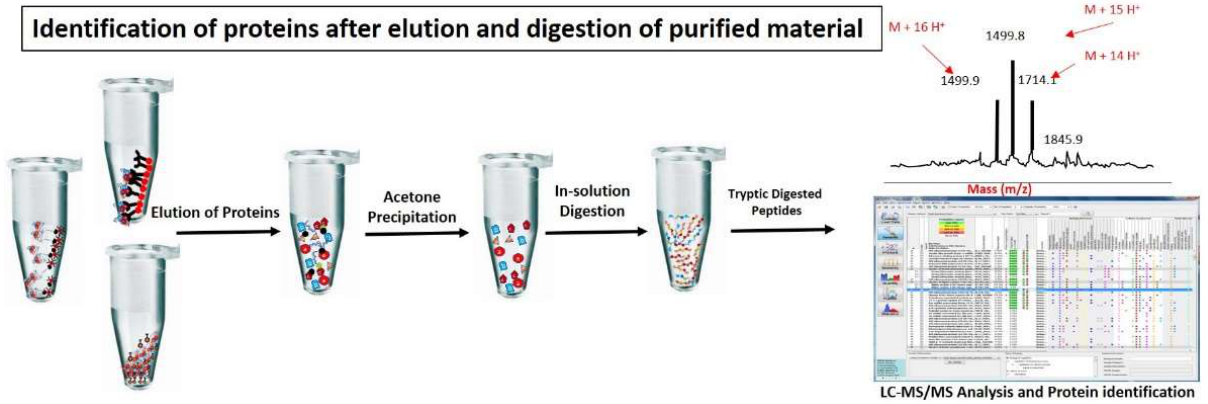
Figure 3. Identification of proteins after elution and digestion of purified material: Chromatin proteins are normally eluted from chromatin complexes using glycine or 3× Laemeli method. Eluted proteins are further purified by acetone precipitation method or SDS-page to remove excessive salts and trypsin digested. Tryptic digested peptides are further processed for identification and quantification of proteins through MS/MS analysis. Table 1. Approaches to identify specific chromatin locus associated proteome.